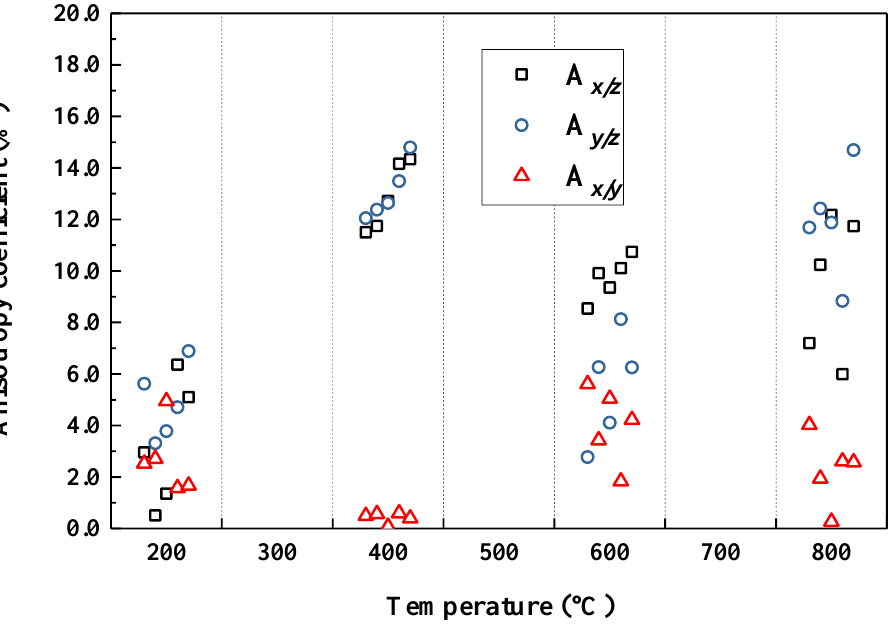
Figure 14. Anisotropic coefficients of SIC norite after treatment.